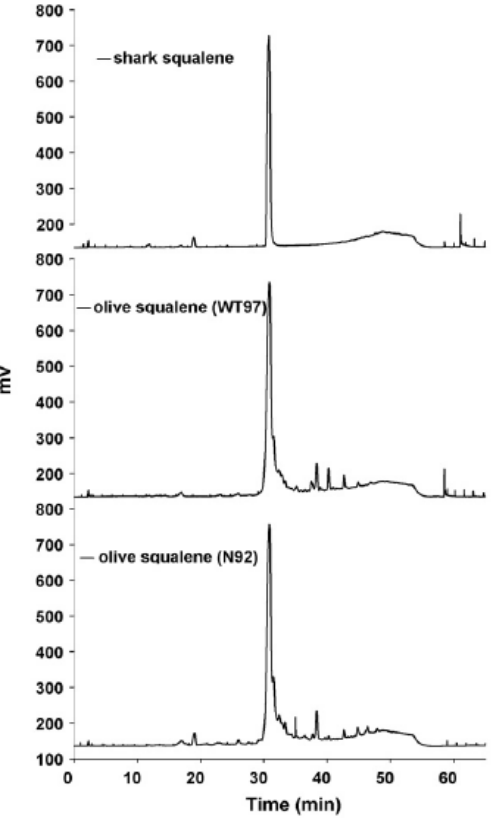
Figure 4. HPLC analysis with charged aerosol detection of squalene and impurities from shark or olive sources. Figure taken with permission from reference